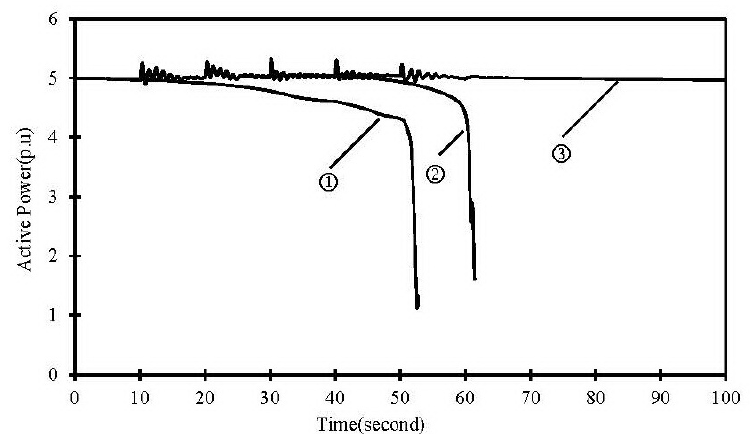
Figure 15. Output active power of bus Yimin.